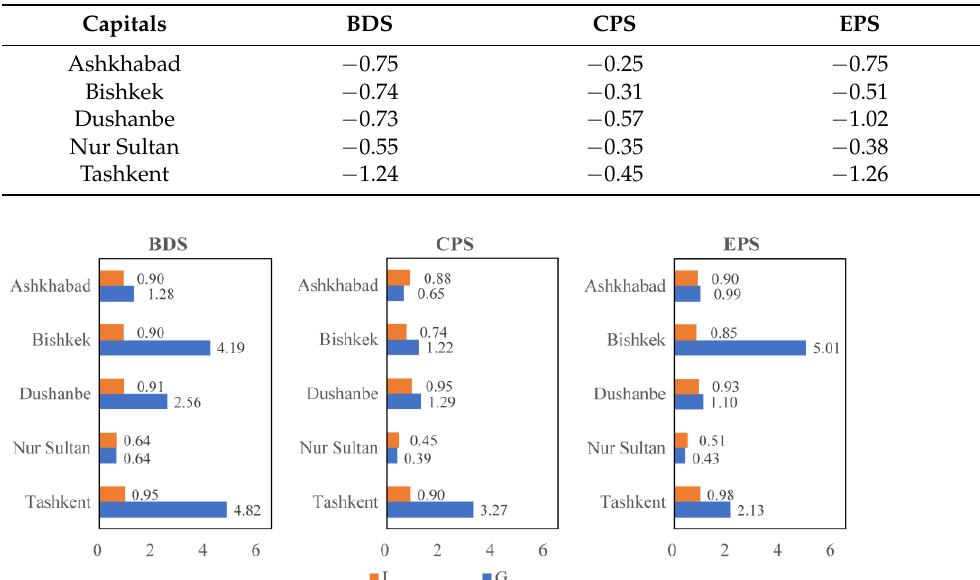
Table 4. The carbon storage losses resulting from urban expansion (Tg).